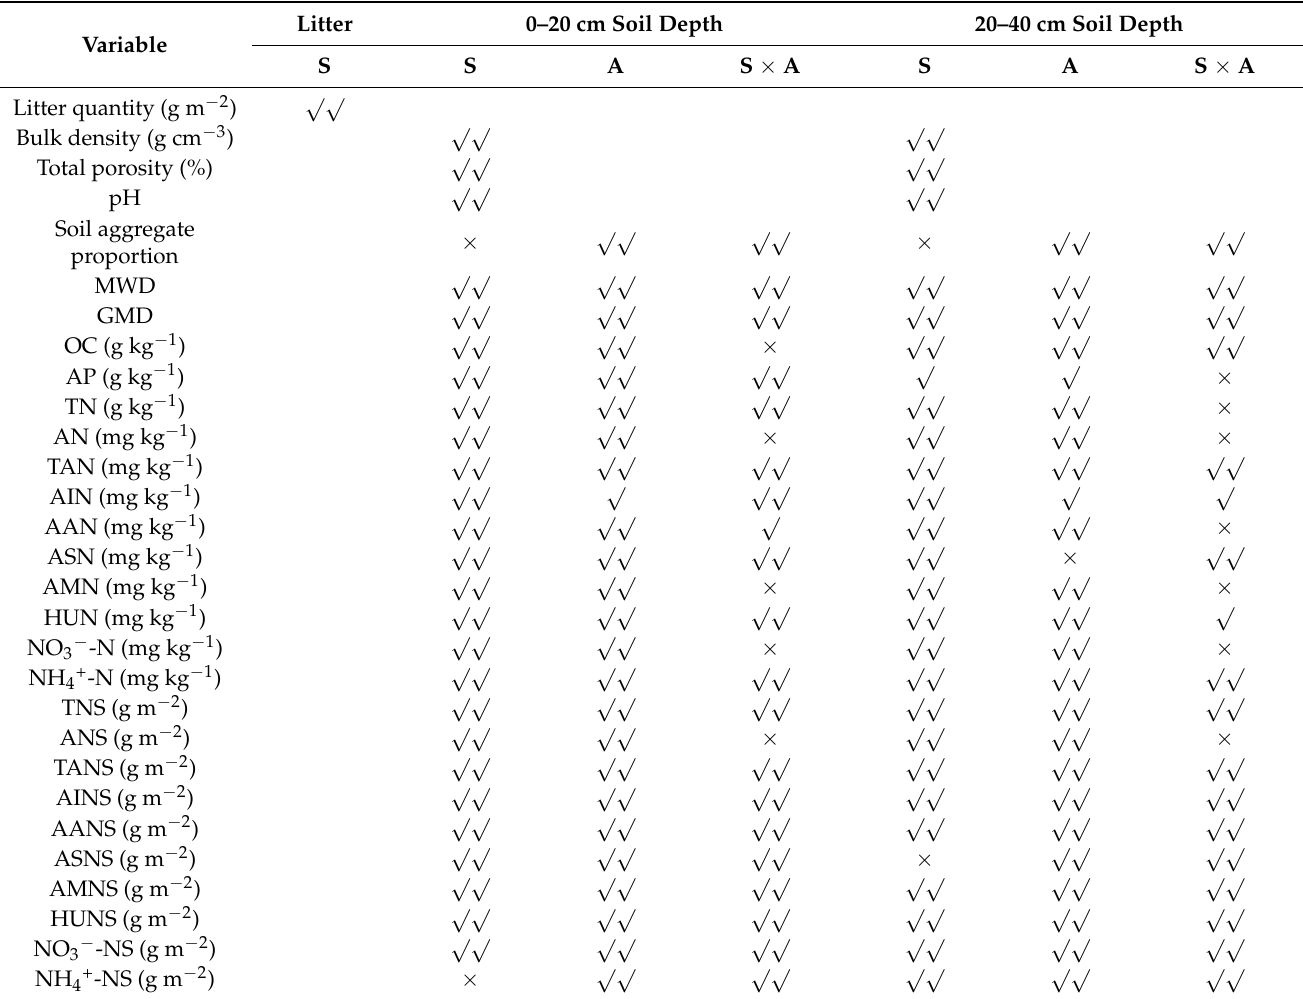
Table 1. Litter and soil properties as influenced by aggregate size and stand type in Chinese fir ( Cunninghamia lanceolata (Lamb.) Hook)